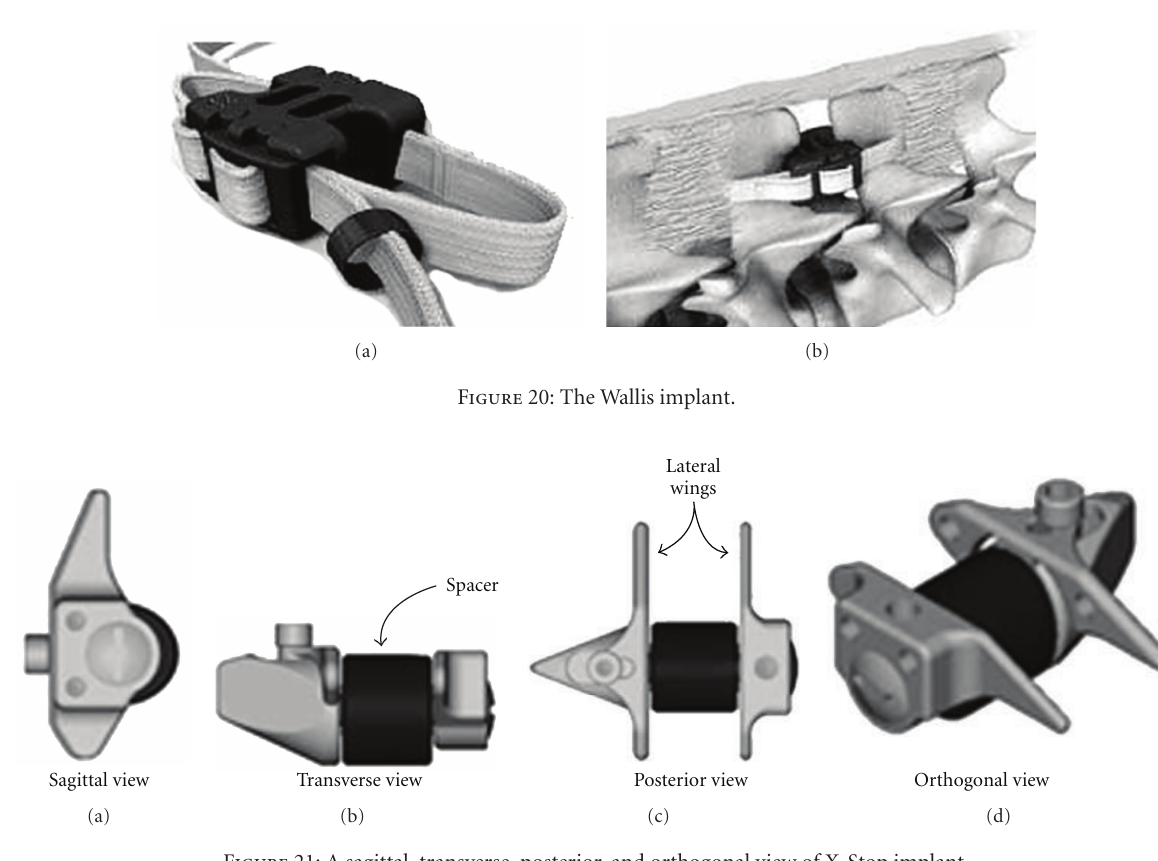
Figure 21: A sagittal, transverse, posterior, and orthogonal view of X-Stop